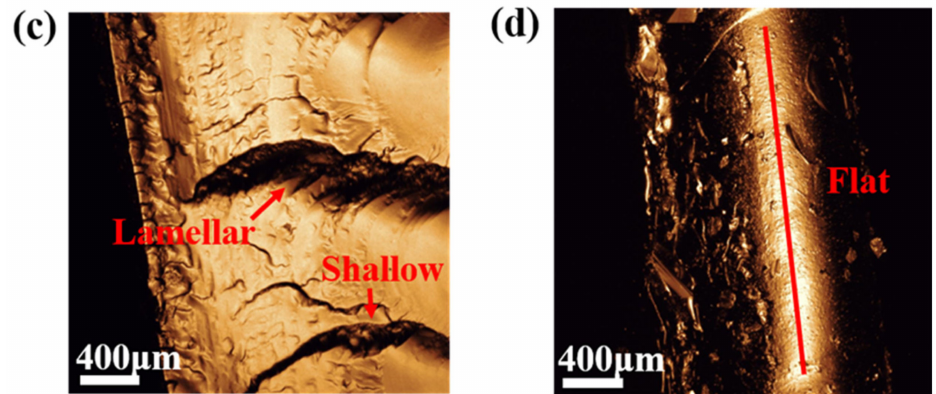
Figure 16. Fracture morphology of PS-PEG hydrogels. ( a ) PS7-PEG. ( b ) PS14-PEG. ( c ) PS21-PEG. ( d ) PS28-PEG.